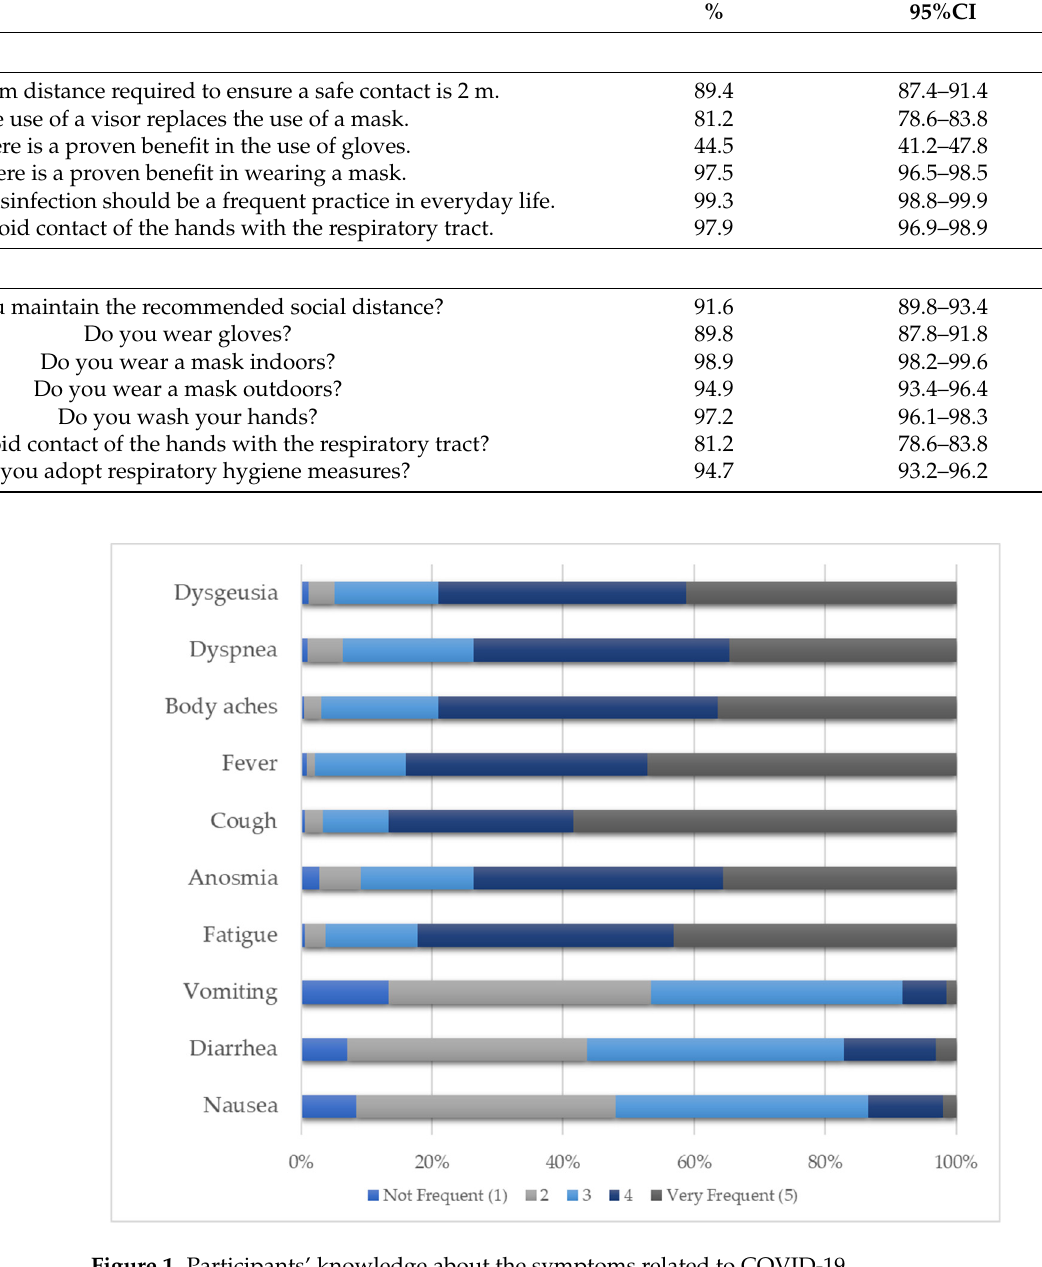
Table 2. ( A ) Frequency of adequate responses to each question that assessed knowledge. ( B ) Frequency of adequate responses to each question that assessed attitudes.